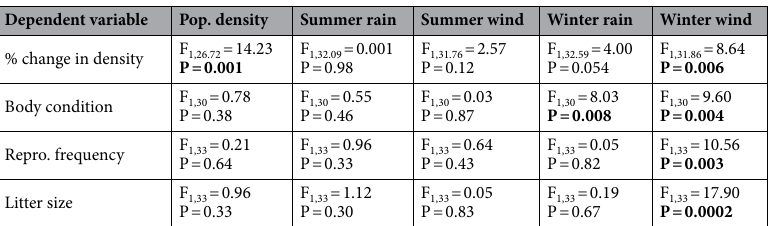
Table 1. Results of statistical analyses of annual changes in population densities (numbers of individuals within 350 × 20 m study areas) of turtle-headed sea snakes ( Emydocephalus annulatus ) in three populations. Site (population) was included as a random factor in all analyses, but site effects are not shown. Columns show results of fixed-effect tests (degrees of freedom, F, P) for population density (“pop. density”) the preceding year, and for rainfall and wind speeds in both summer (October to April) and winter (May to September). Boldface font indicates significant values at P <